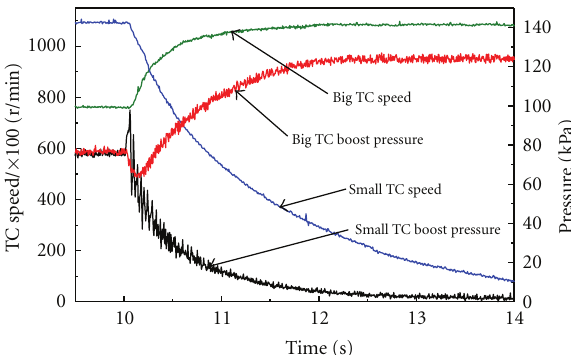
Figure 8: Process from the big TC to the 2TC with the two valves activated synchronously.